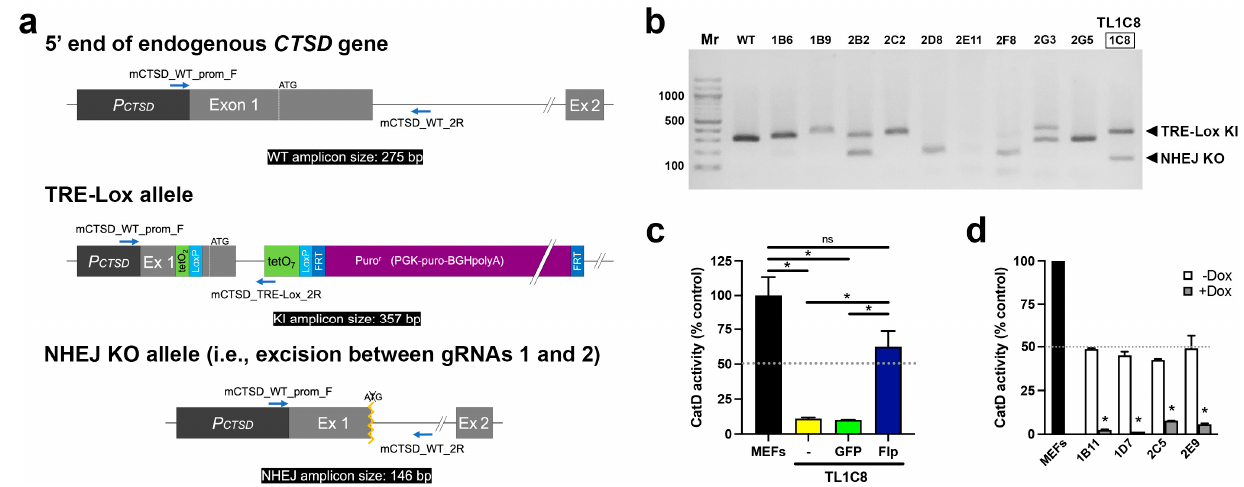
Figure 2. Development and characterization of TRE-Lox KI cell lines targeting the endogenous CTSD gene of mouse embryonic fibroblasts (MEFs). ( a ) Overview of the genotyping strategy, including the relative position of different primers (blue arrows) and the predicted sizes of different PCR amplicons (black boxes) used to distinguish different possible outcomes of insertion of the TRE-Lox construct via Cas9-assisted homologous recombination. The main possibilities include (but are not limited to) the following: (1) the unmodified endogenous murine CTSD allele (top); (2) insertion of the TRE-Lox KI insert as designed (middle); and (3) nonhomologous DNA end joining (NHEJ) resulting (in this case) in the excision of the segment of DNA between gRNA1 and gRNA2 (bottom, see Supplementary Materials Figure S1). ( b ) Genotyping of a subset of clones obtained after selection of individual puromycin-resistant clonal lines. The two bands within clone 1C8 (referred to as TL1C8) were excised, sequenced, and confirmed to be amplified from one allele carrying the TRE-Lox KI insert (upper band) and another allele featuring NHEJ, which results in functional knock-out (KO) of CTSD (sequences provided in Supplementary Materials Figure S5a–c). ( c ) CatD proteolytic activity in wild-type MEFs, or TL1C8 cells transiently transfected with empty vector (yellow), GFP (green) or Flp recombinase (dark blue). Note the low level of CatD activity in TL1C8 cells, which is reversed by transfection with Flp recombinase, resulting in activity close to the expected value of 50% of wild-type MEFs (gray dotted line). ( d ) CatD activity in several clonal lines of TL1C8-Flp cells stably expressing rtTRKRAB incubated for 4 d in the absence or presence of Dox (100 ng/mL). Note how, in the absence of Dox (white columns), all tested clones harbor CatD activity that is very close to 50% of the levels within MEFs (gray dotted line), as expected, whereas in the presence of Dox (gray columns), CatD activity is greatly decreased. Data in ( c , d ) are mean ± SEM of 4 replicates. * p < 0.05; ns =